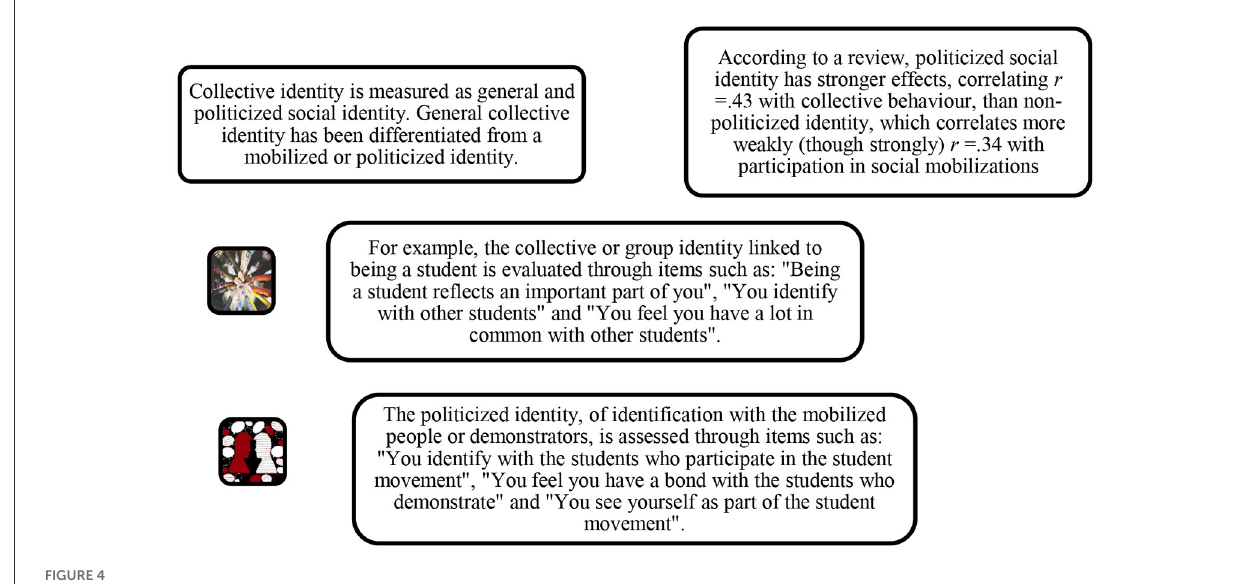
FIGURE4 Measures of collective identity. Source: van Zomeren et al. (2008).